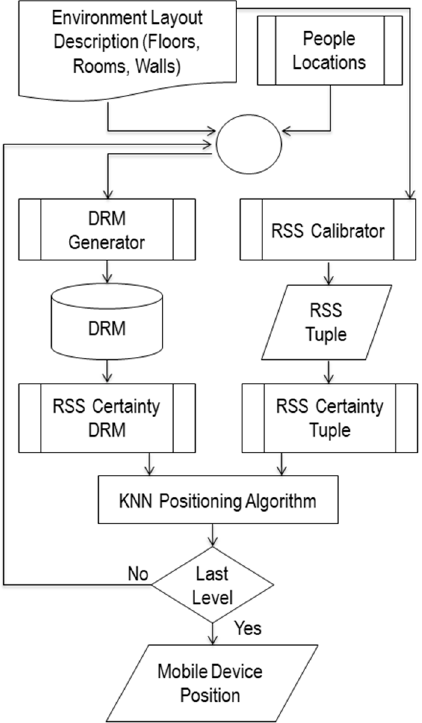
Figure 1. The proposed adaptive indoor positioning model (DIPS).